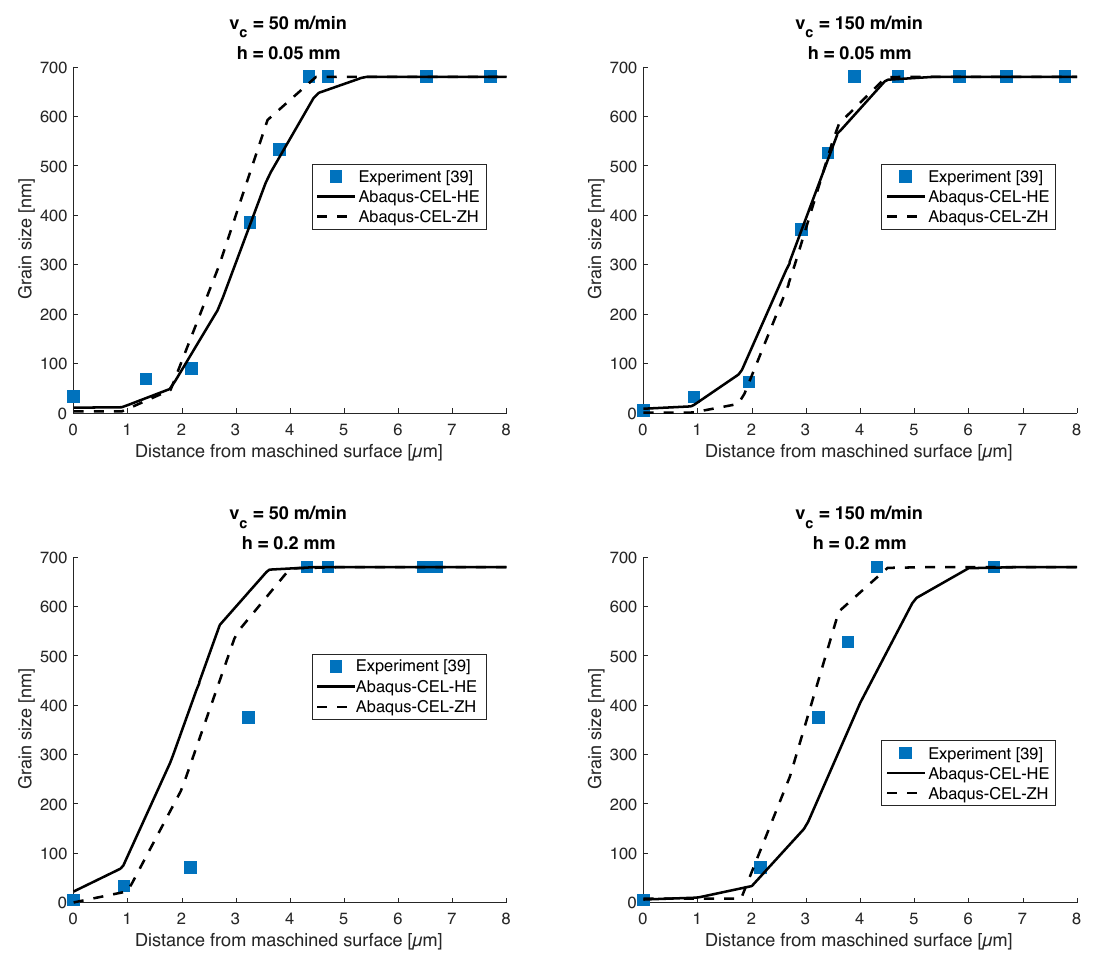
Figure 8. Comparison of the predicted and experimentally measured grain size evolution with Zener-Hollomon and Helmholtz energy models at different cutting speeds and undeformed chip